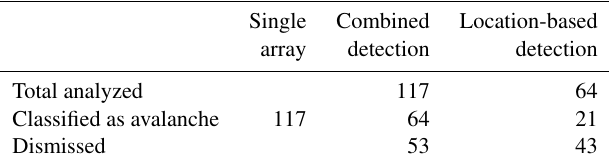
Table 1. Number of analyzed events, events classified as an avalanche and dismissed events for the different steps in the classifi- cation workflow. For the single array classification, the total number of analyzed and dismissed events cannot be provided as the entire time series was